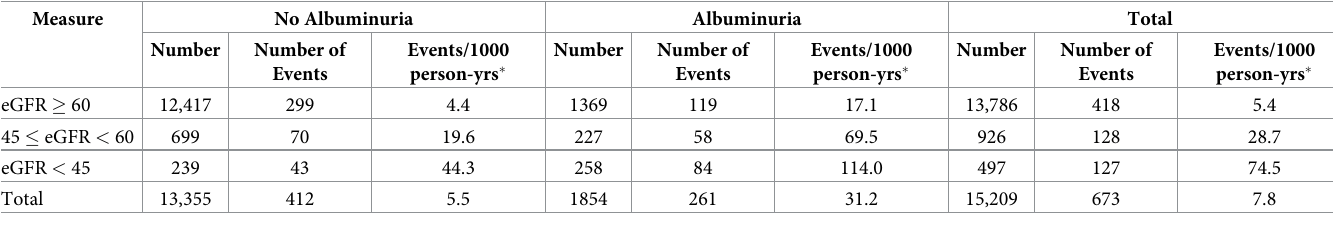
The median follow-up duration for the Chinese population was 6.9(IQR: 5.0–7.6) years, and that for the US population was 3.7 (IQR: 2.3–5.2) years. The US population had a signifi- cantly higher mortality rate than the Chinese population. Both US and Chinese population showed higher mortality rate at lower levels of eGFR, presence of albuminuria and the combi- nation of lower eGFR and albuminuria (Table 2 and Table 3). In spline analysis by country, eGFR of (cid:20) 30 ml/min/1.73m 2 was significantly associated with higher risk of mortality in the US. A higher risk of mortality was observed with higher ACR in both countries, while the significant association first emerged at ACR of 30mg/g in the Chinese population and at 10mg/g in the US population (Fig 1). When the splined eGFR were stratified by albuminuria, we can observe among the US population that declined eGFR showed increased risk of mortality when at levels of (cid:20) 30 ml/min/1.73m 2 when albuminuria is present, while the corresponding associations were not significant at 15 ml/min/1.73m 2 of eGFR when albuminuria is not present. Due to the remarkably wide confidence interval in effect measurement, HRs at 15 ml/min/1.73m 2 of eGFR were not shown in the Chinese popu- lation. Significant associations can be observed at 30 ml/min/1.73m 2 of eGFR when albumin- uria is present, but is null when albuminuria is absent (Fig 2). In the Cox regression analyses based on the combined dataset from both countries, we observed a trend of increased risk for mortality through the decreased levels of eGFR in both the presence and absence of albuminuria. The significant associations can be detected when eGFR was less than 45 ml/min/1.73m 2 when albuminuria was absent among both the Chinese and US population. When albuminuria was present, the significant can be observed through all eGFR levels in both countries. No significant interactions were detected between each level of the combined kidney damage indicator and country (Table 4). Consistent results were found in the sensitivity analysis after excluding the 2009–2010 NHANES data (n = 5,611) (S1 Table.). Table 3. Crude Death Rates of the participants from the US.